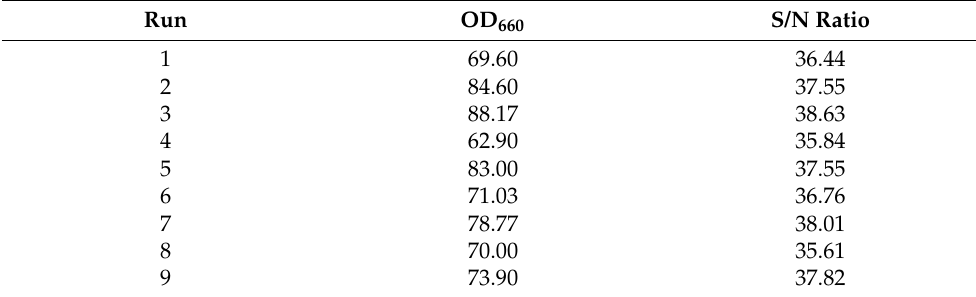
Table 1. The results of L 9 orthogonal array experiments for different culture conditions on D. macquariensis strain D50 growth and corresponding S/N ratios.